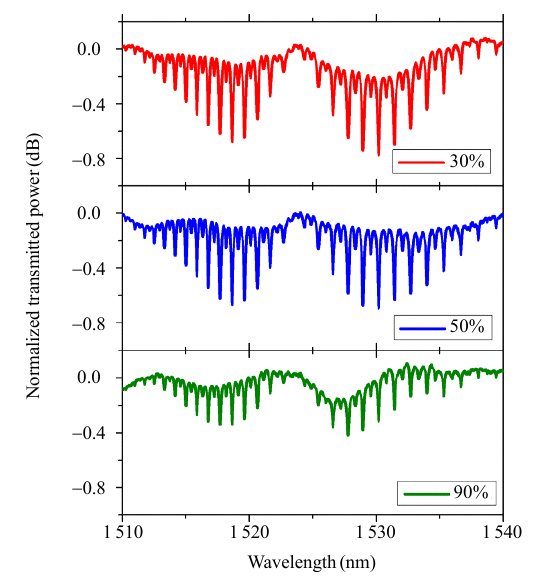
Fig. 5 Normalized transmitted power for the tapered fibers inside the taper cages (with material filling densities of 30%, 50%, and